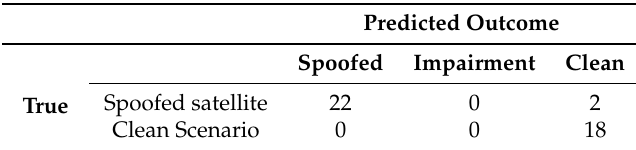
Table 2. Confusion matrix for the two types of datasets processed.